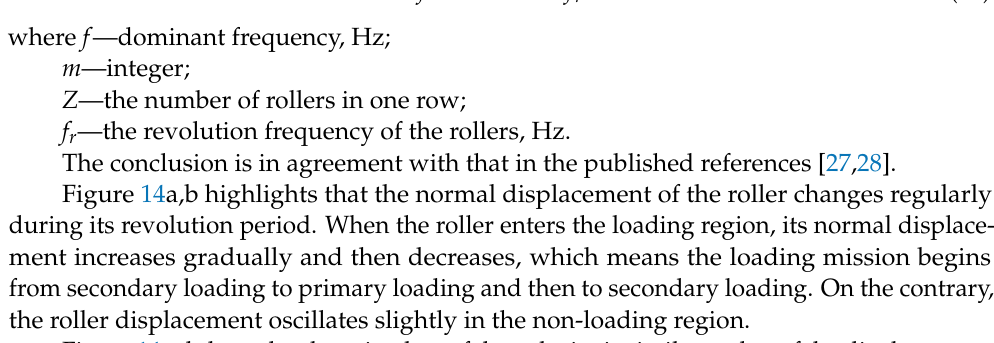
during its revolution period. When the roller enters the loading region, its normal